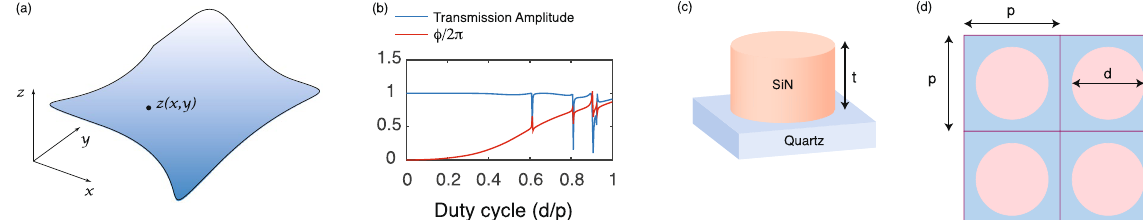
Figure 1. Mapping a freeform surface onto a metasurface: An arbitrary freeform surface is shown in ( a ). The corresponding height z(x, y) is converted into a discretized phase profile using the pillar parameters shown in ( b ). The parameters in ( b ) are capable of producing a full cycle of phase shifts and also maintain large regions of continuous, near unity transmission amplitude. ( c ) and ( d ) are simple schematics of a metasurface with thickness t, periodicity p, and diameter